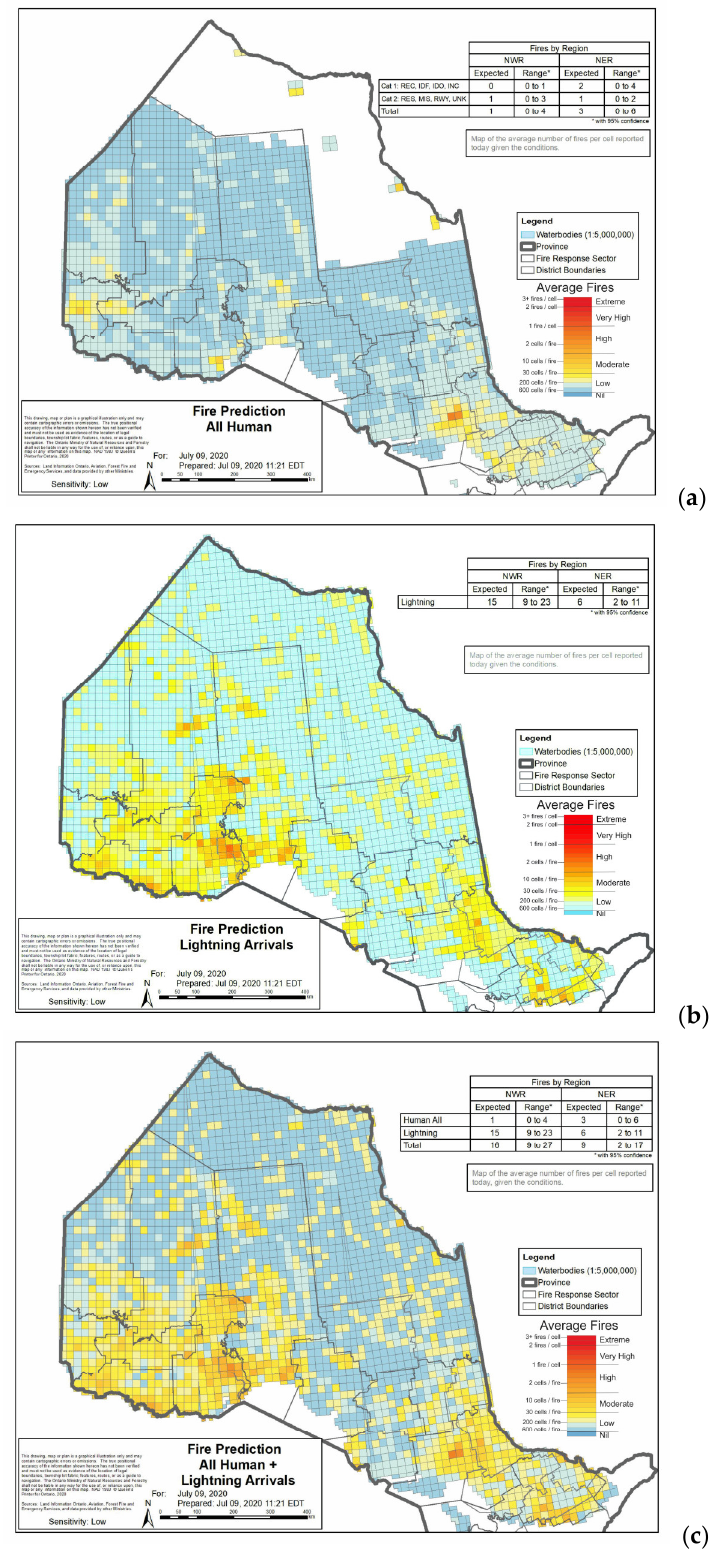
Figure 7. Examples of fire occurrence prediction maps that use the categorization and colouring in Table 6: ( a ) human-caused; ( b ) lightning-caused; ( c ) total. The legend uses units of fires/cell and cells/fire to make the magnitudes integer. Larger versions are in the supplementary material.